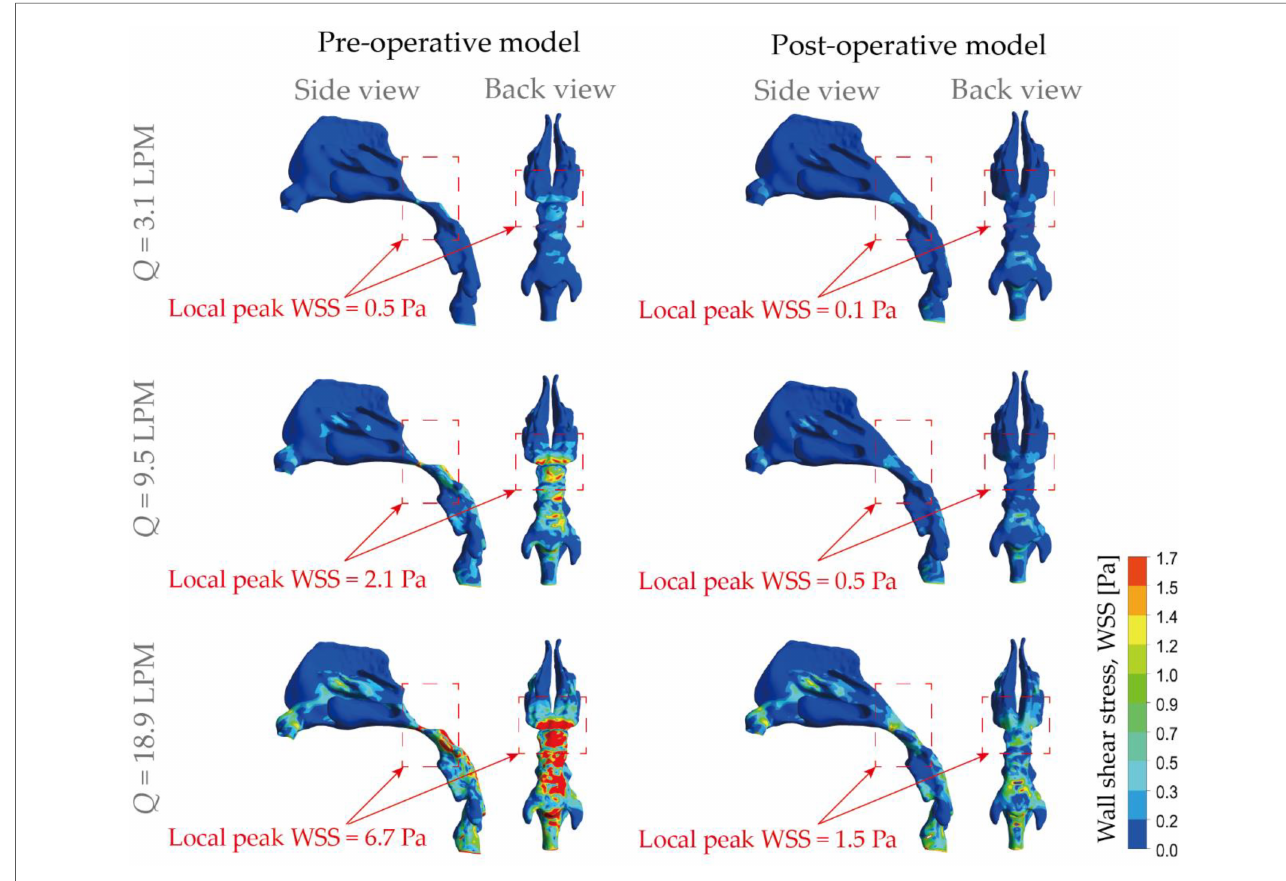
FIGURE 8 Comparison of wall shear stress (WSS) contours pre- and post-operation, under different inhalation fl ow rates ranging from 3.1 LPM to 18.9 LPM.